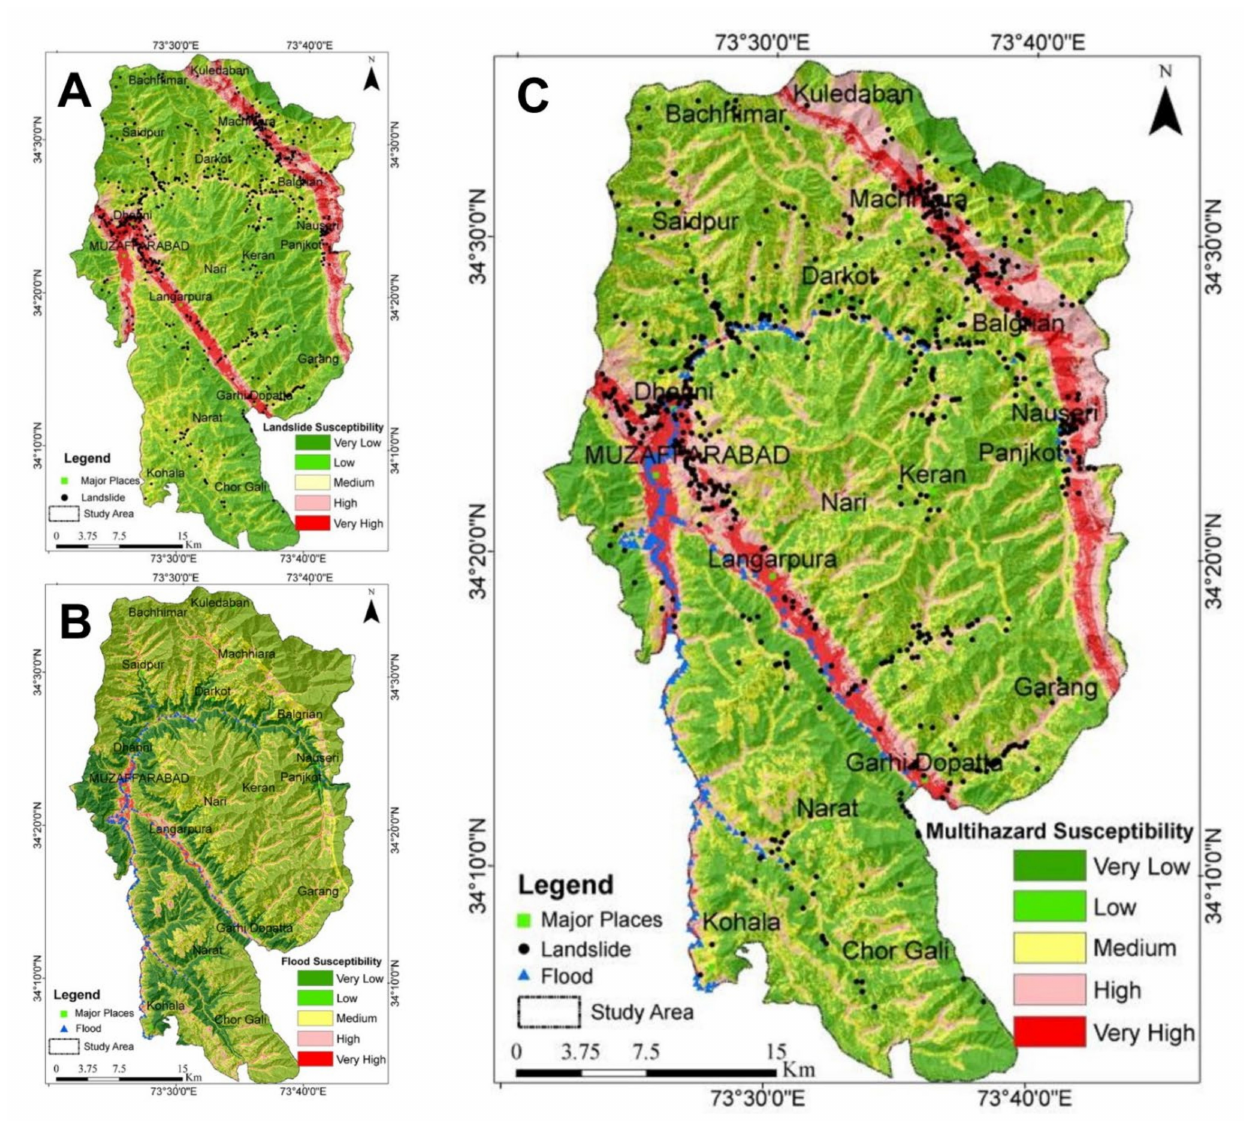
Figure 14. Susceptibility assessment maps with geo-hazard locations. ( A ): Landslide susceptibility assessment map, ( B ): flood susceptibility assessment map, and ( C ): multi-hazard susceptibility assessment